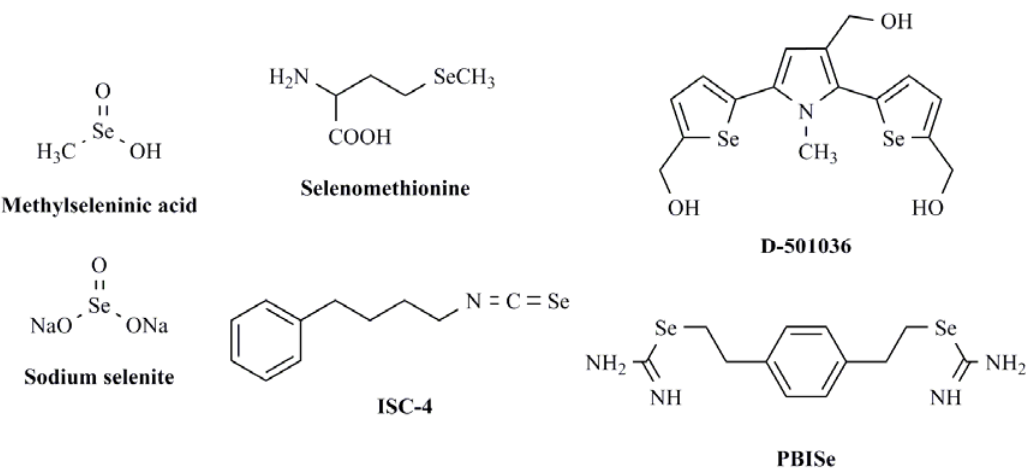
Figure 2. Chemical structures of some selenocompounds with kinase